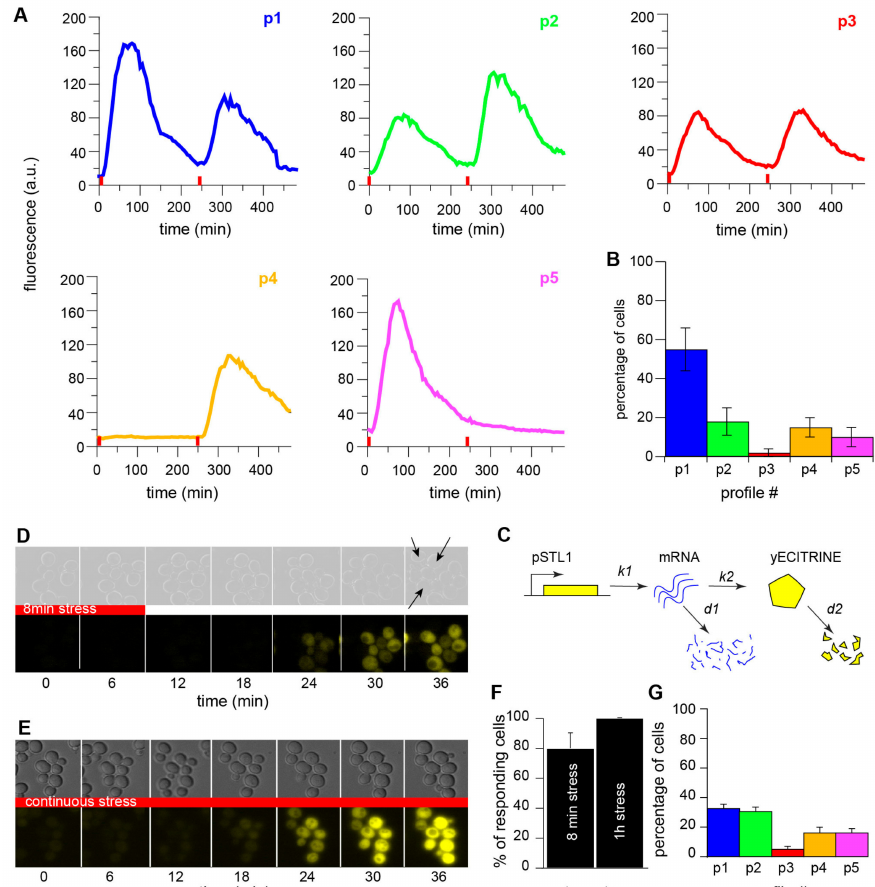
Figure 2. ( A ) Examples of the five typical single-cell response profiles. Although the single-cell analysis revealed dynamic variability in the responses of single cells, we defined five typical response profiles (p1 to p5). ( B ) Single-cell clustering. Based on peak fluorescence values, the dynamic variability of the responses was clustered into five typical fluorescence responses. Errors bars represent the standard errors. A total of 708 cells were analyzed in three independent experiments. ( C ) Modeling of gene expression upon stress in a memory-free system. Stochastic simulations with the Gillespie algorithm were used to model transcription of the fluorescent reporter and protein translation upon stress. ( D ) Time series of images of cells subjected to 8 min stress. The arrows on the last bright field image show the cells that did not respond to the stress. ( E ) Time series of images of cells subjected to continuous stress. All cells responded to the stress. ( F ) Quantification of responsive cells. After exposure to 8 min stress, 80% of cells showed a response, whereas 100% of cells responded to 1 h stress. ( G ) Single-cell quantification of computed cells according to the five typical response profiles. In this case, the model includes a randomly selected transcription delay of between 0 and 10 min for each computed cell. This delay was also varied for the two stresses. The simulation was run twice and the peak fluorescence values were used to cluster the responses of the computed cells according to the five typical response